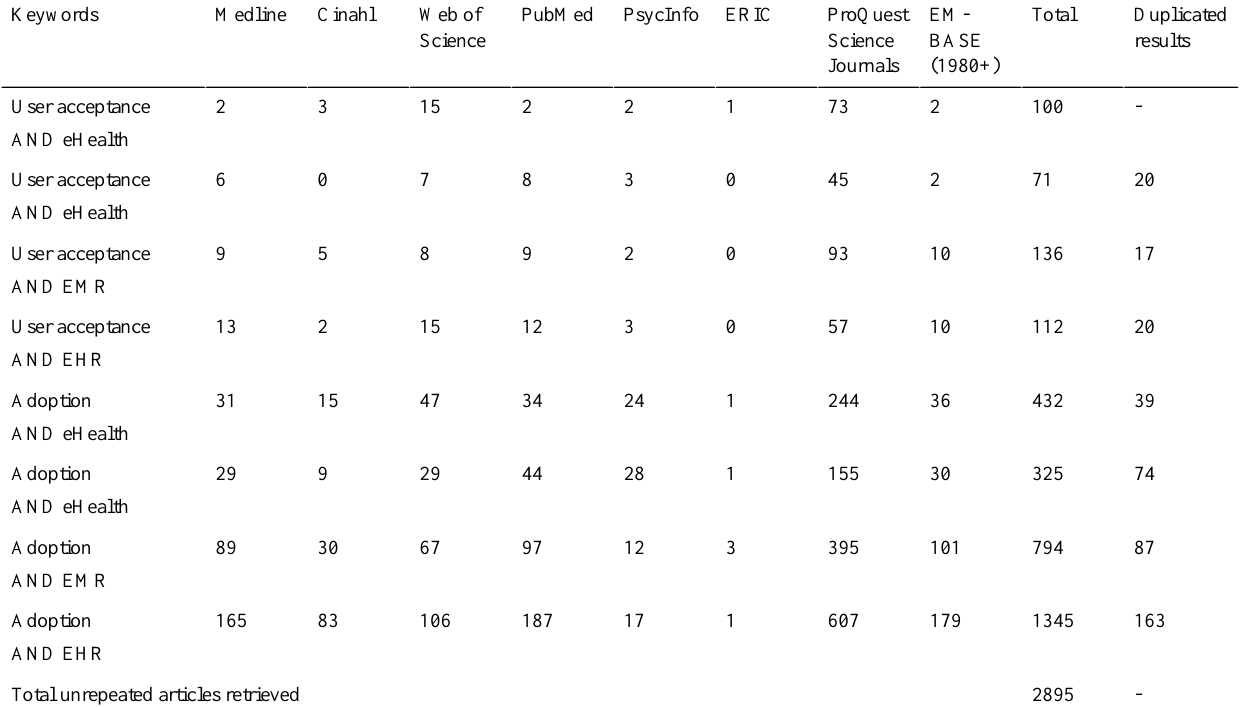
Table 1. Identification of papers for review from 8 online